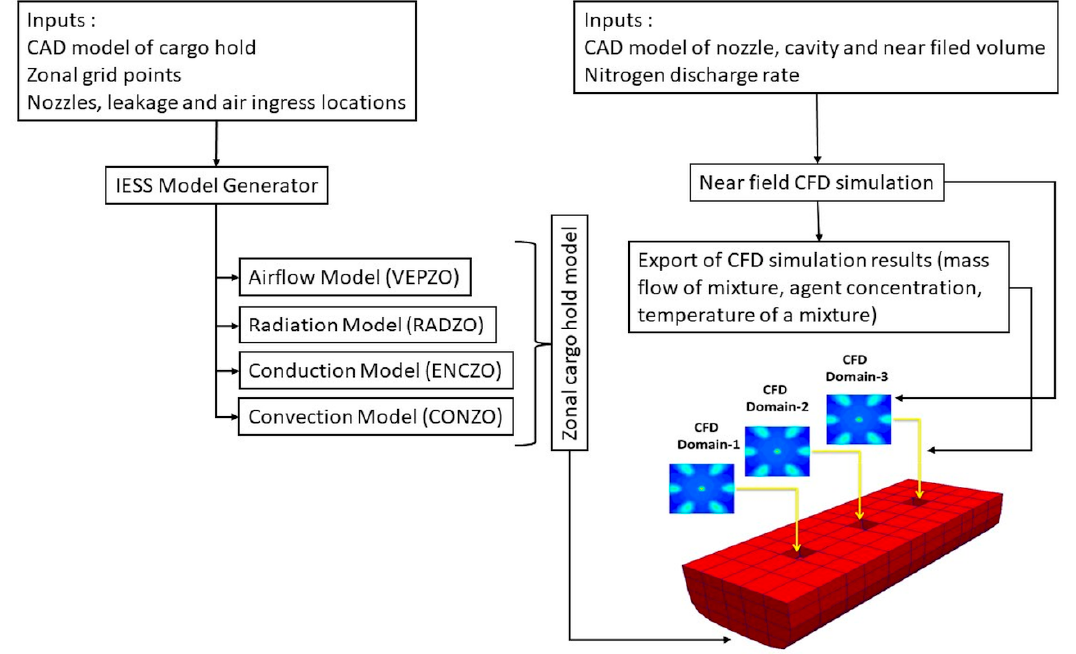
Figure 4. Workflow for cargo model generation .